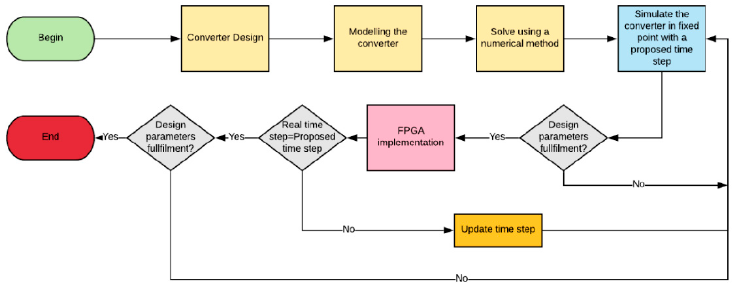
Figure 1. Flow diagram of the methodology used to develop the hardware in the loop (HIL) simulation.